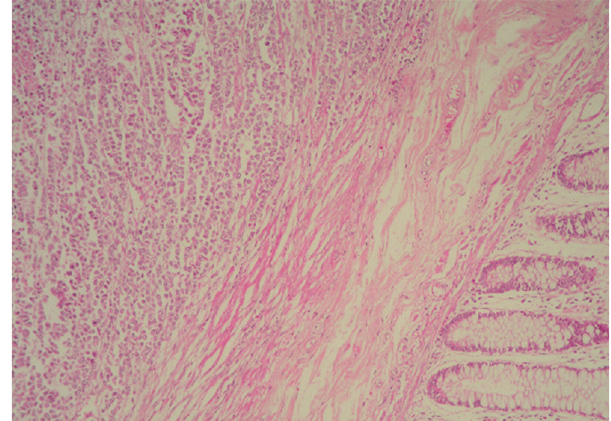
Figure 4 - Anal melanoma. Cross-section of the mucosa surface region (H&E 6 100).